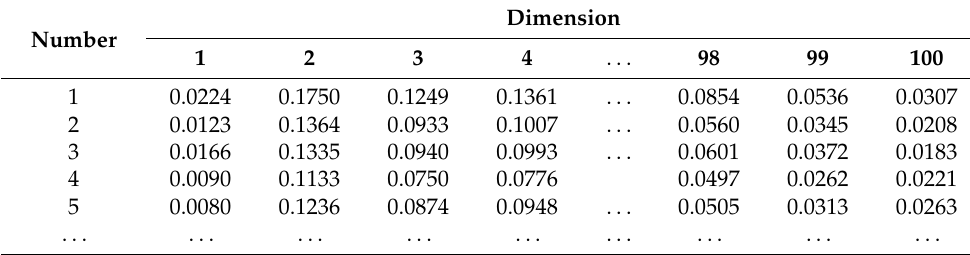
Table 3. Aircraft fault text feature vector extracted by Word to Vector